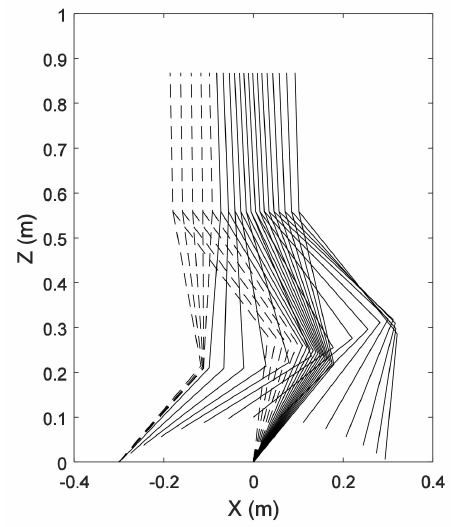
Figure 9. Stick diagram of one